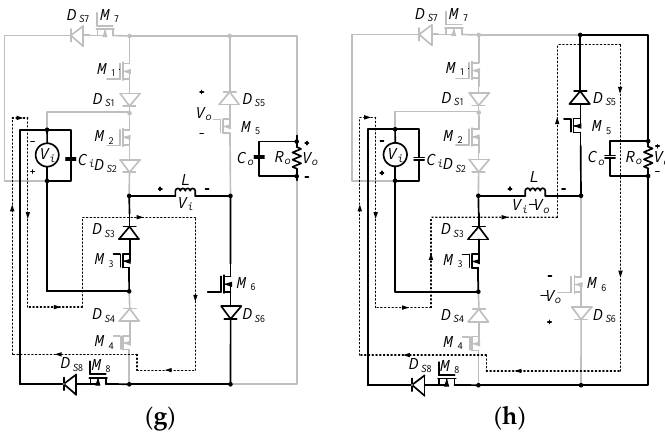
Figure 5. Parts ( a – d ) and ( e – h ) represent the non-inverting and inverting boost operation respectively. Table 1. Operating modes in proposed circuit in boost mode. The AC voltage controller has non-inverting and inverting boost characteristics, which may be realized by operating the suggested converter in modes ‘ E ’, ‘ F ’, and ‘ G ’, ‘ H ’, respectively. The control of duty cycle regulates their voltage gains. The input current in boost operation is inherently continuous, having low THD than that of buck or buck-boost operation.